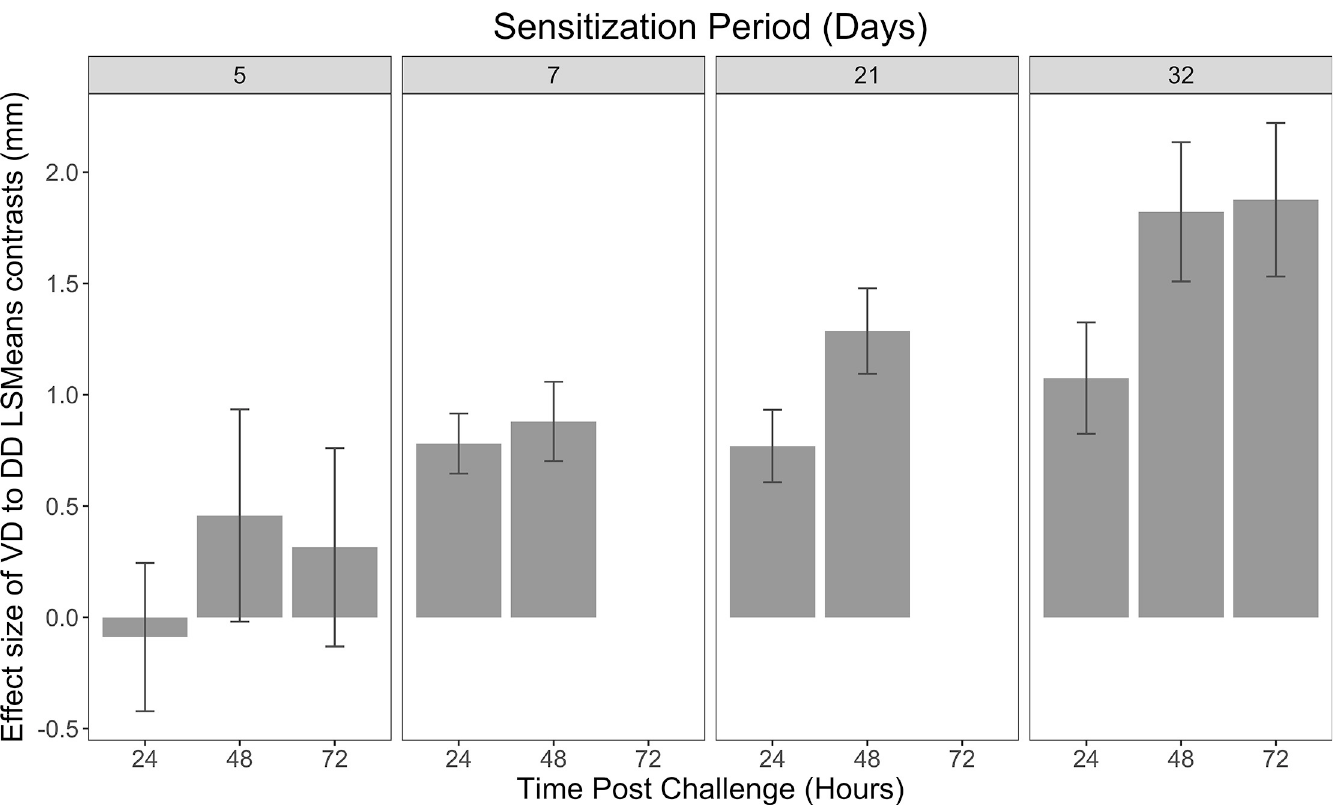
Fig 4. Hapten-specific ear swelling effect differences between sensitization periods and time of data collection. While 7, 21 and 32 day sensitization periods yielded significant hapten-specific inflammation responses, the 32 day sensitization period showed the largest effect of prior sensitization. Data shown for 24, 48, and 72 hour (if applicable) ear thickness. Error bars represent standard error.